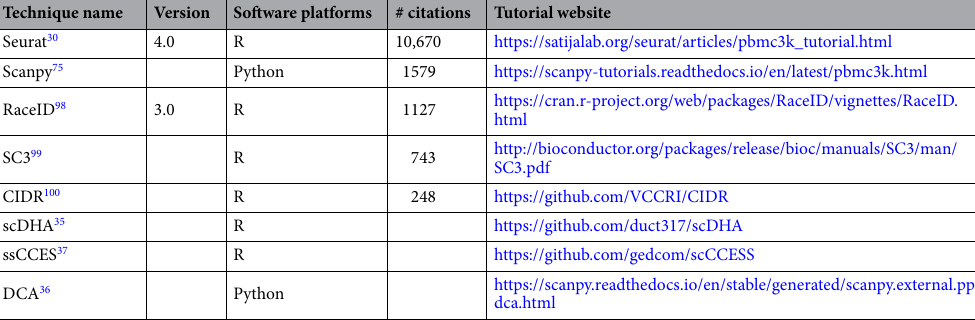
Table 2. Non-AI scRNAseq clustering tools.